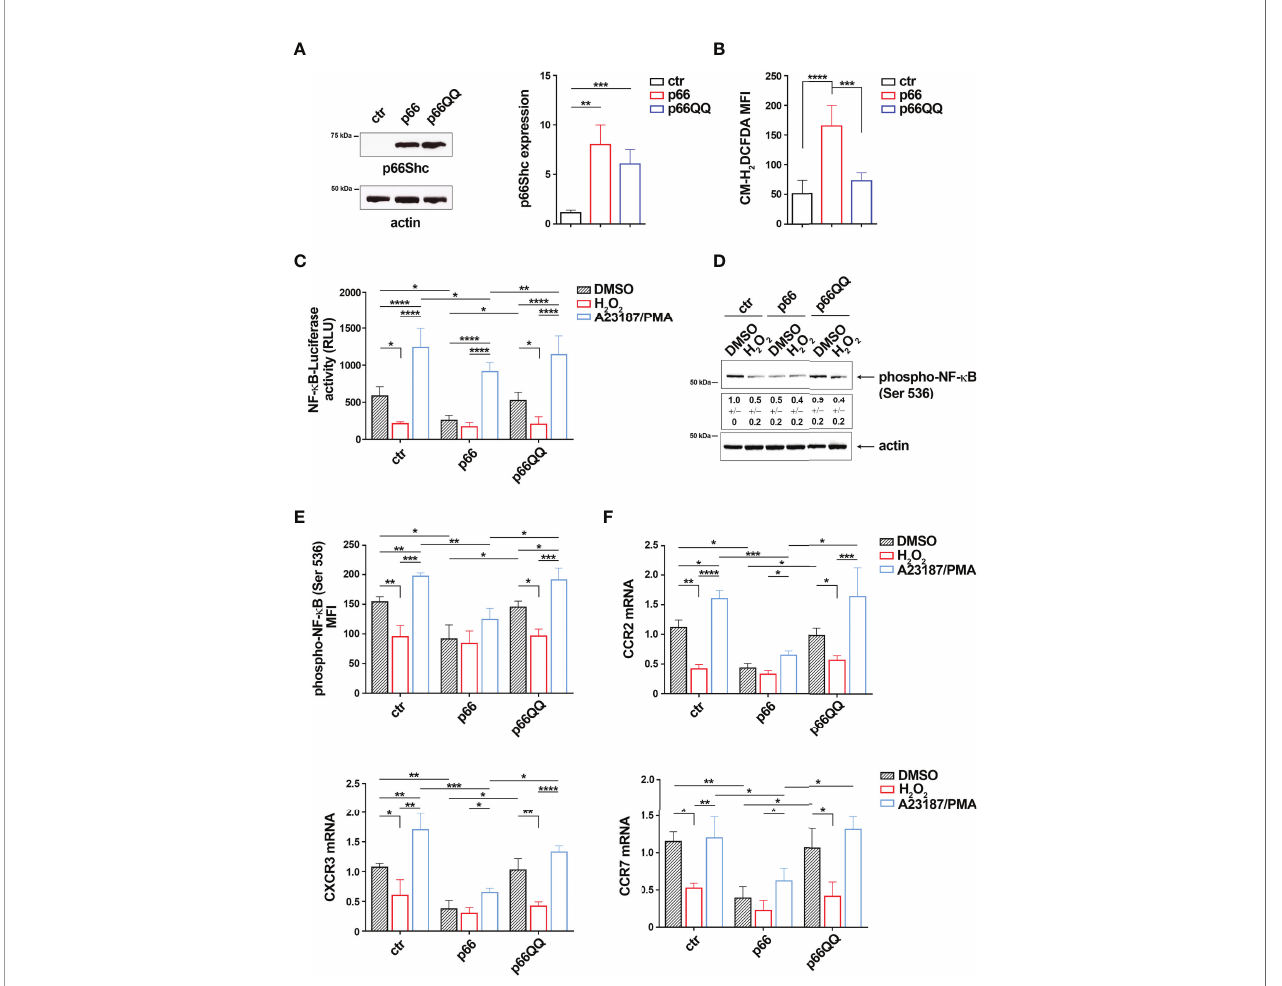
FIGURE 4 | The pro-oxidant activity of p66Shc inhibits NF- k B activity in MEC-1 cells. (A) Immunoblot analysis with anti-Shc antibodies of postnuclear supernatants of MEC-1 cells stably transfected with empty vector (ctr) or with a vector encoding either wild-type (p66) or mutated (p66QQ) p66Shc. The stripped fi lters were reprobed with anti-actin antibodies. Molecular weights (kDa) are indicated on the left of the panel. The quanti fi cation of three independent experiments is shown on the right. (B) Flow cytometric analysis of ROS intracellular content in MEC-1 transfectants stained with CM-H 2 DCFDA (n independent experiments = 3). (C) Quanti fi cation of the luciferase activity in MEC-1 stable transfectants transiently transfected with the NF- k B-luciferase reporter construct and then treated for 6 h with either DMSO, or 100 m M H 2 O 2 or A23187+PMA. Data are expressed as relative luciferase units (RLU) (n independent experiments = 4). (D, E) Immunoblot (D) and fl ow cytometric (E) analysis of phospho-NF- k B (Ser536) in MEC-1 transfectants, transiently transfected with the NF- k B-luciferase reporter construct and then treated for 30 min as above. The stripped fi lters were reprobed with anti-actin antibodies. Molecular weights (kDa) are indicated on the left of the panel. [ (D) n independent experiments = 3; (E) n independent experiments = 4]. (F) Quantitative RT-PCR analysis of CCR2, CXCR3 and CCR7 mRNA in MEC-1 cells transfected and treated as in (C) The relative gene transcript abundance was determined on triplicate samples using the ddCt method and normalized to HPRT1 (n independent experiments = 4). Mean ± SD. C-F. Anova two-way test, Multiple Comparison. (A, B) . Mann Whitney Rank Sum Test. p ≤ 0.0001, ****; p ≤ 0.001, ***; p ≤ 0.01, **; p ≤ 0.05,